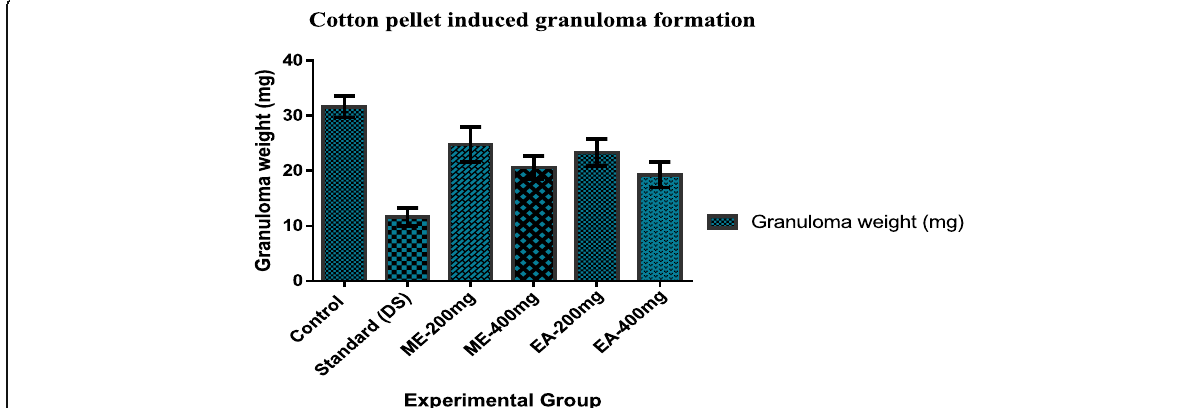
Fig. 2 Effect of Hemigraphis alternata methanolic and ethyl acetate extract treatment on dry granuloma weight after subcutaneous cotton pellet implantation. Difference between initial weight (10 ± 1 mg) and weight after overnight drying was considered to be the dry weight of the granuloma tissue. Each bar represents the mean ± standard error of the mean of five animals